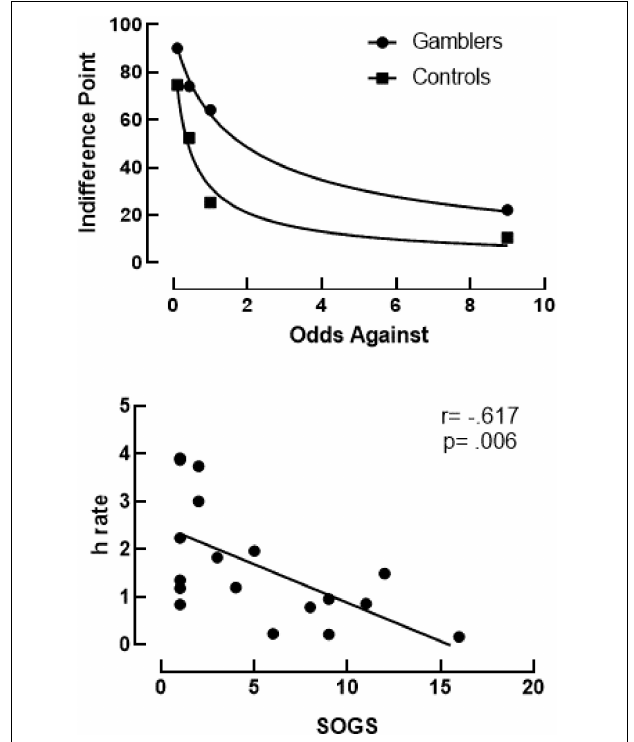
FIGURE 2 | Top panel shows probability discounting curves using Rachlin’s Hyperboloid equation for gamblers ( R 2 = 0.9955) and controls ( R 2 = 0.9703). Bottom panel shows results of a Spearman correlation between discounting rates ( h ) on the y-axis and SOGS scores on the x-axis. The trendline shows a negative correlation of r (18) = -0.617, p =